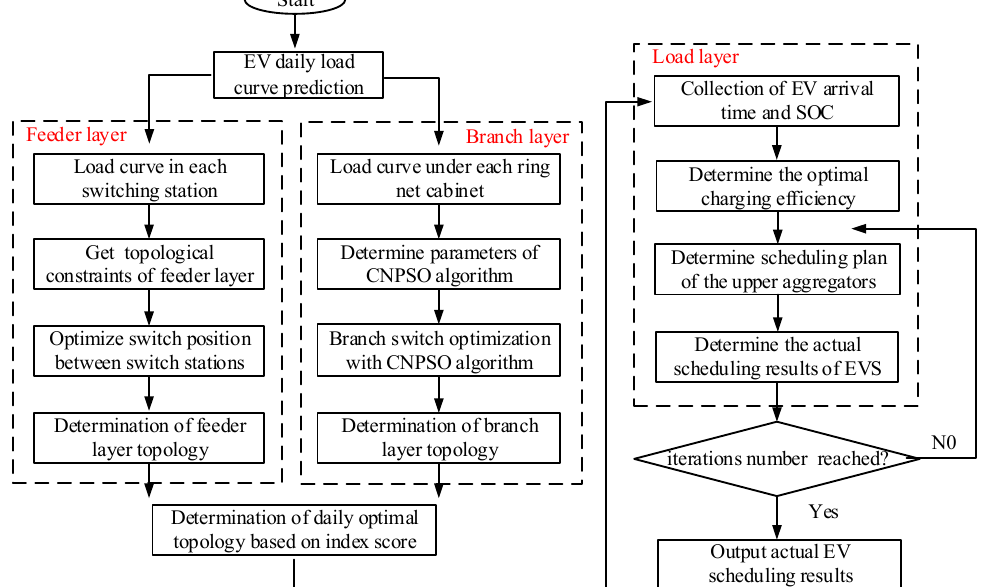
Figure 8. Electric vehicle dispatching strategy diagram considering dynamic topology.